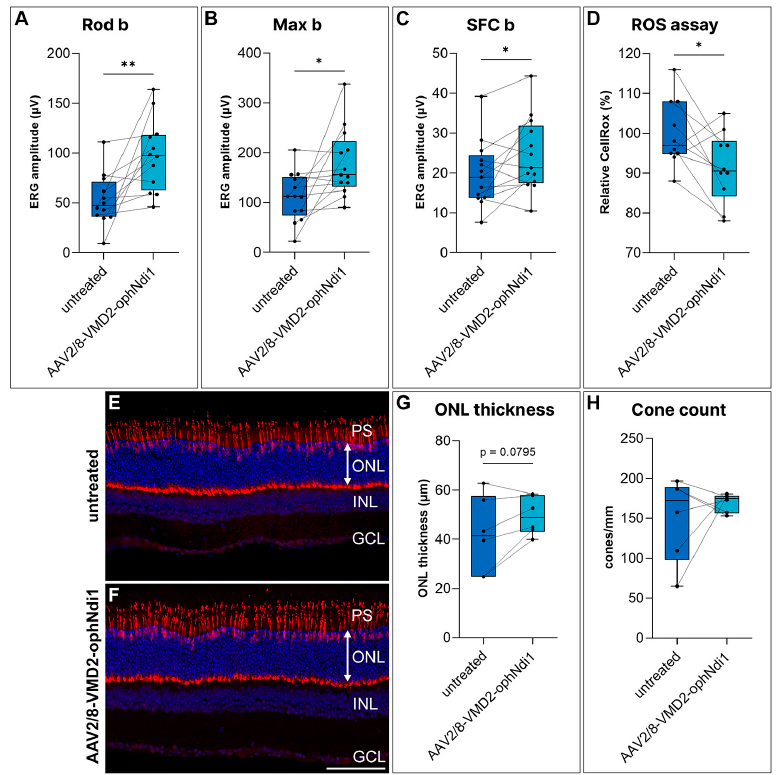
Figure 3. Rescue of the Cfh − / − murine model with AAV2/8-VMD2-ophNdi1. Two-month-old Cfh − / − mice were subretinally injected with 4.5 × 10 8 vg AAV2/8-VMD2-ophNdi1 in one eye, while contralateral eyes received PBS. ( A – C ) Electroretinography (ERGs) of treated eyes compared to untreated contralateral eyes at 8 months ( n = 13). Rod b ( A ), Max b ( B ) and single flash cone (SFC) b ( C ) responses are indicated. ( D ) At 7 months post injections mice were sacrificed, retinal cells dissociated, stained with CellRox TM (marker for ROS) and analysed on an Accuri B6 FACS analyser ( n = 10 mice). Relative median levels of ROS in the single cell and live population of cells from treated and control retinas were compared. At 8 months eyes from untreated ( E ) and AAV2/8-VMD2- ophNdi1-treated ( F ) mice were fixed, cryosectioned and stained with Arr3 immunocytochemistry (cone-specific antibody, red) and DAPI (nuclear stain, dark blue). ( G ) The outer nuclear layer (ONL) thickness ( µ m) and ( H ) cone numbers (cones/mm) were determined ( n = 6). PS = photoreceptor cell segments; INL = inner nuclear layer; GCL = ganglion cell layer. * p < 0.05; ** p < 0.01; paired t -test. Scale bar for retinal sections ( F ) = 100 µ